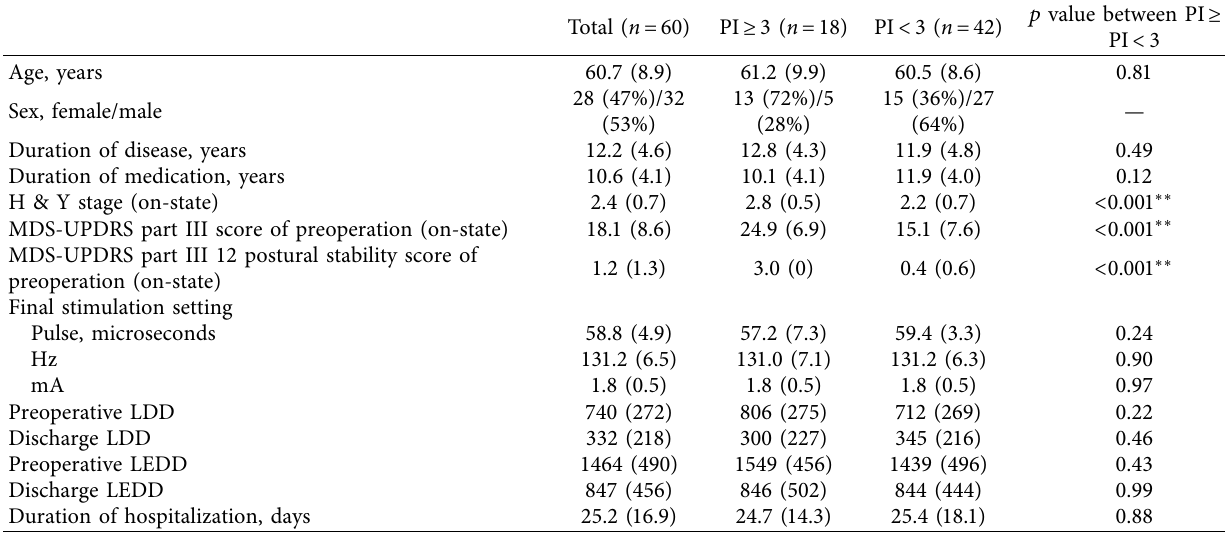
Table 1: Demographic data of the participants.